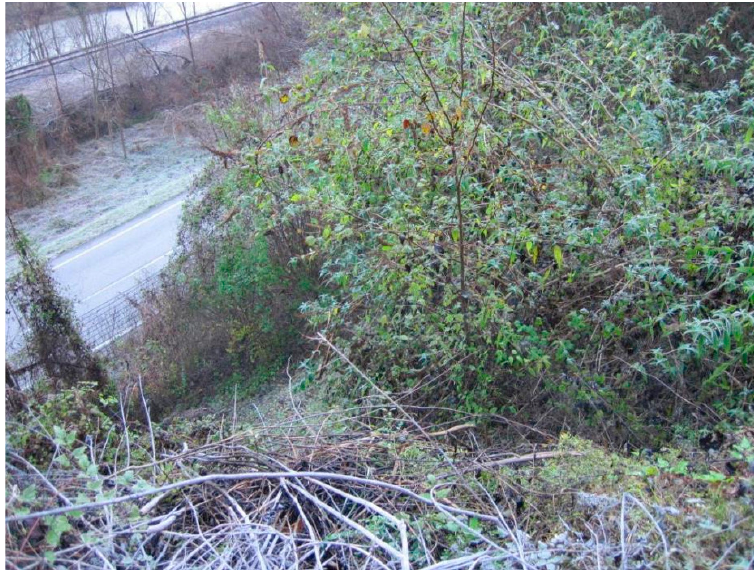
Figure 11. Landslide photograph code 025021_08c.